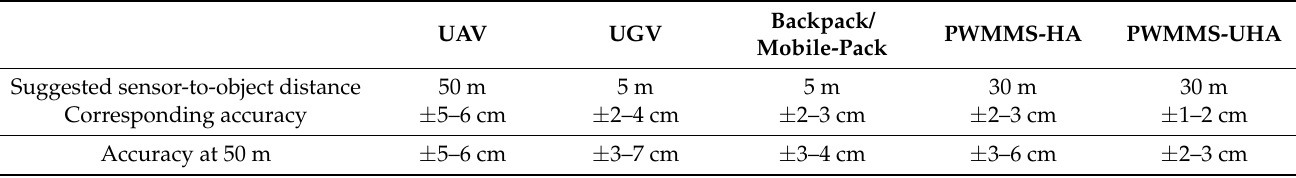
Table 3. Expected accuracy of the ground coordinates evaluated using the LiDAR Error Propagation calculator